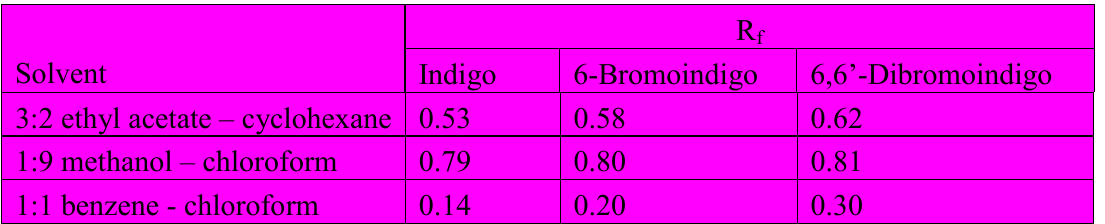
Table 4. R s of N-monoacetylindigos in various solvent mixtures. f